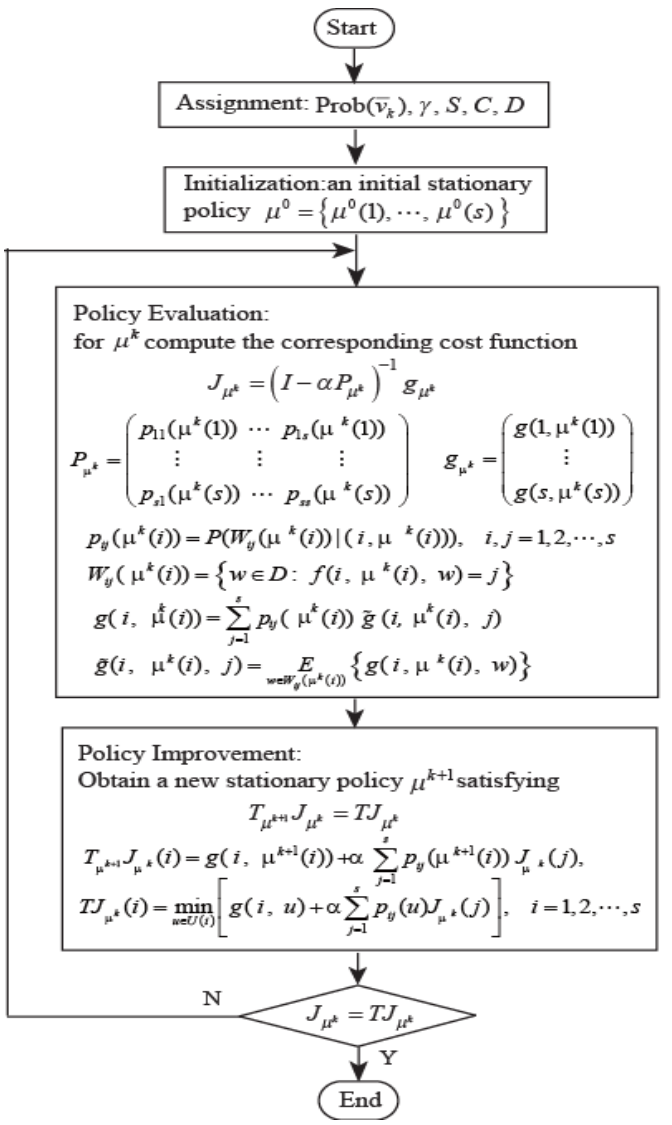
Figure 9. The procedure of the control policy